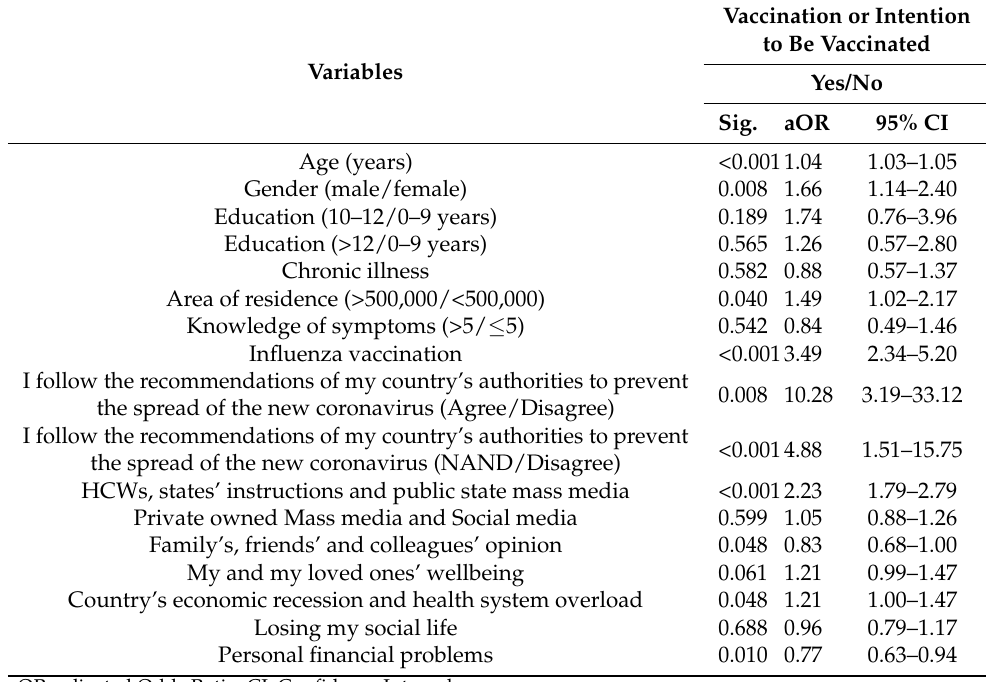
Table 5. Multivariate analysis, vaccination intention, data from survey 5.